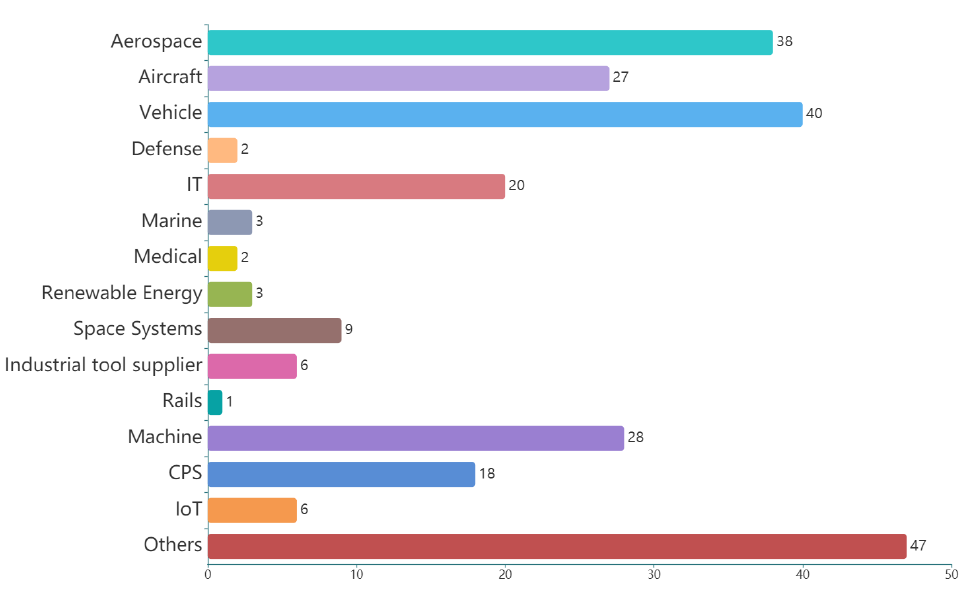
Figure 4. Application areas of MBSE tool-chains.